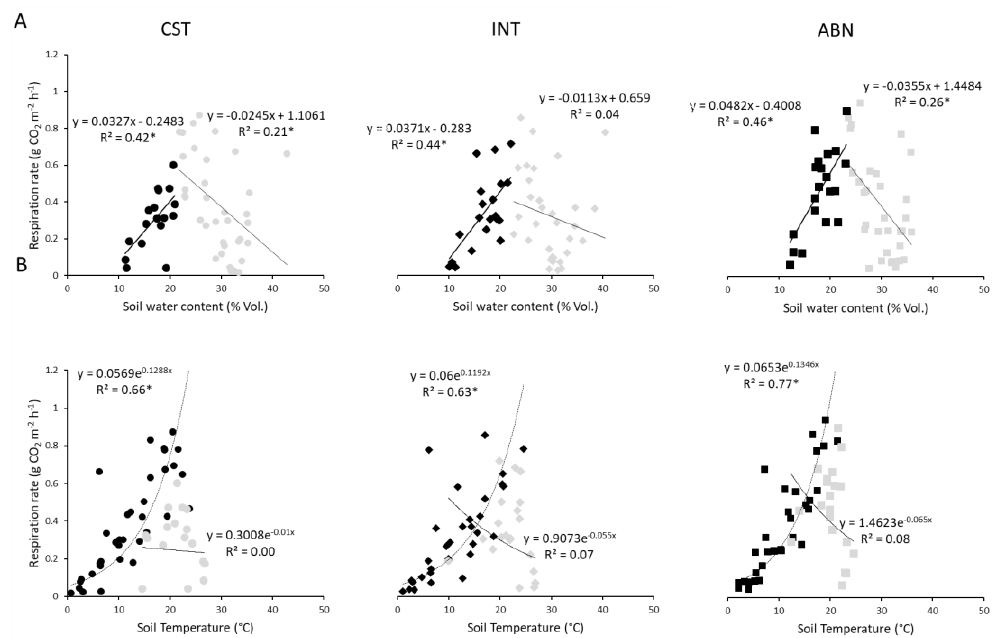
Figure 3. Relationships between the variations in the soil respiration and the soil water content at 10 cm depth ( A ) and the soil temperature at 10 cm depth ( B ) for customary management (CST), intensive use (INT), and abandonment (ABN). Black symbols refer to data below the threshold for soil water content modeling and above the threshold for soil temperature modeling. Gray symbols refer to data above the threshold for soil water content modeling and below the threshold for soil temperature modeling. Data are means of three replicates per treatment. * p < 0.05.